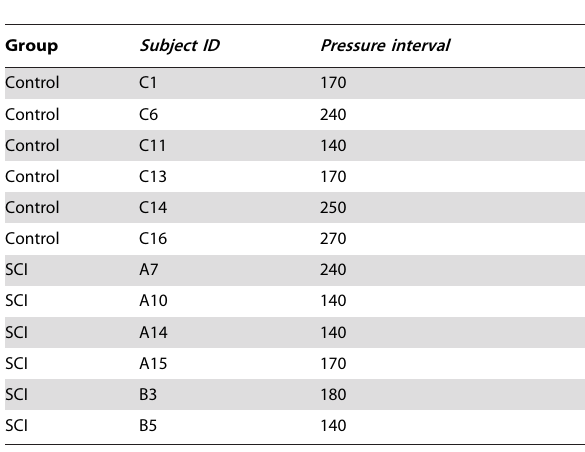
Table 2. Subject-specific minimal value of the pressure interval that would be predicted to result in substantial tissue